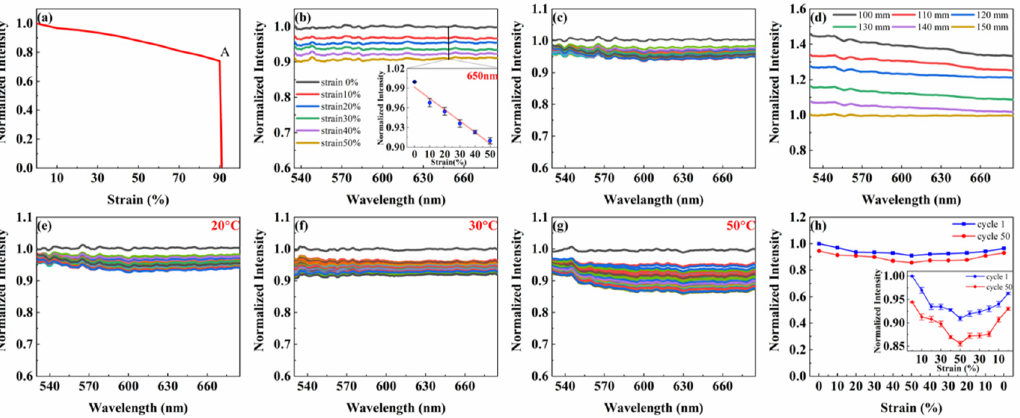
Figure 3. Mechanical and optical properties of the fibers. ( a ) Strain-normalized intensity curve of flexible fiber at wavelength 650 nm (the point “A” indicates that the fiber breaks only when the strain is greater than 90%). ( b ) Normalized spectra of flexible optical fiber with increasing strain from 0 to 50%. The inset shows the relationship between the normalized intensity at 650 nm and the applied tensile strain. ( c ) Dynamic tensile test of a flexible fiber being stretched 50 cycles at the strain range 0–50%. ( d ) Propagation loss of flexible fiber, measured in air by cutback method. Fibers for deformation sensing. Dynamic tensile test of flexible fiber being stretched 50 cycles with 50% applied peak strain at different temperatures, ( e ) 20 °C, ( f ) 30 °C, ( g ) 50 °C. ( h ) Comparison of the first cycle and the 50th cycle in tensile test at room temperature. The different color lines in ( c, e–g ) represent each stretch cycle.